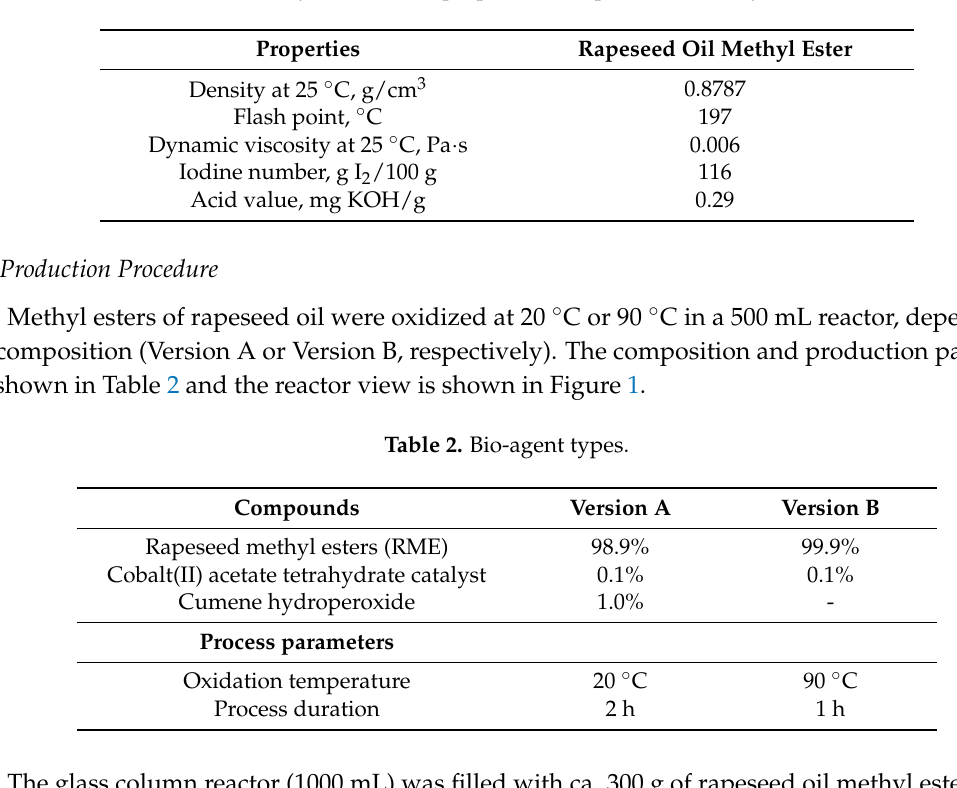
Table 1. Physicochemical properties of rapeseed oil methyl ester.